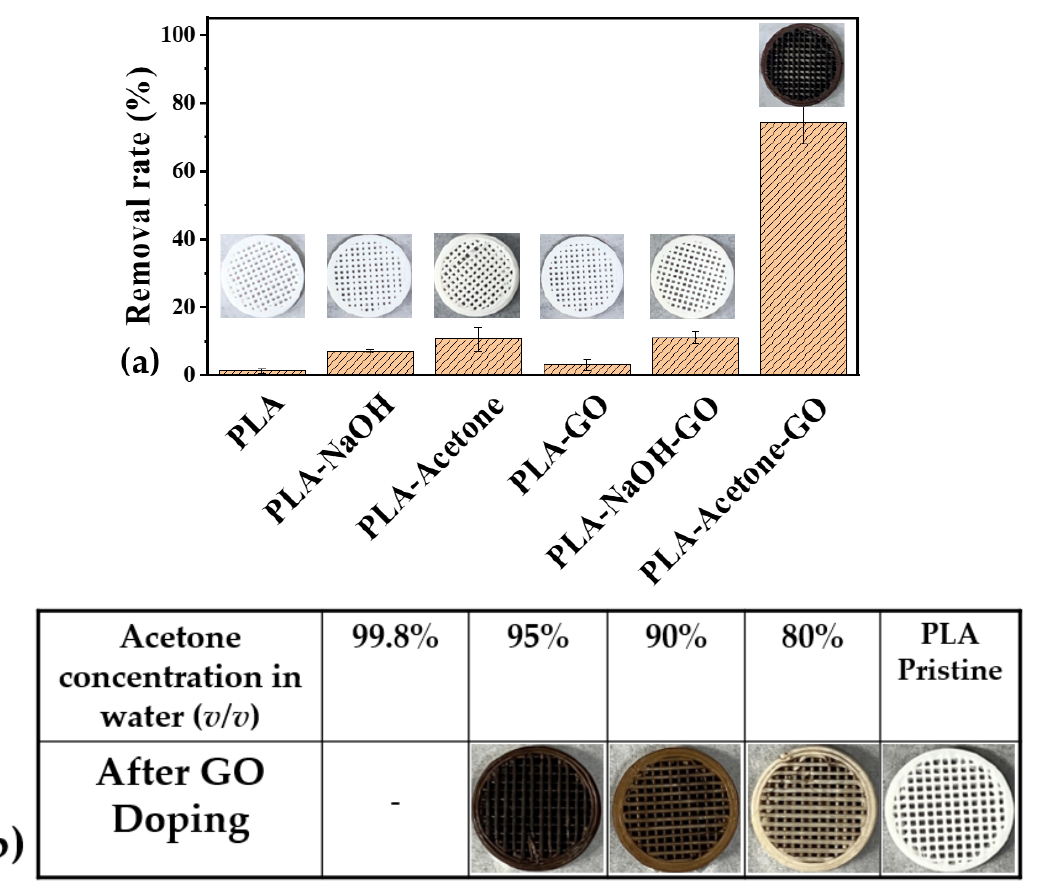
Figure 2. ( a ) Results of MB adsorption on PLA filters subjected to different surface treatments and ( b ) GO doped on PLA scaffolds treated with different concentrations of acetone (experimental condition: [MB] 0 = 50 mg/L, pH = 6.5, reaction time = 24 h, average filter weight for MB adsorption = 0.2 mg).